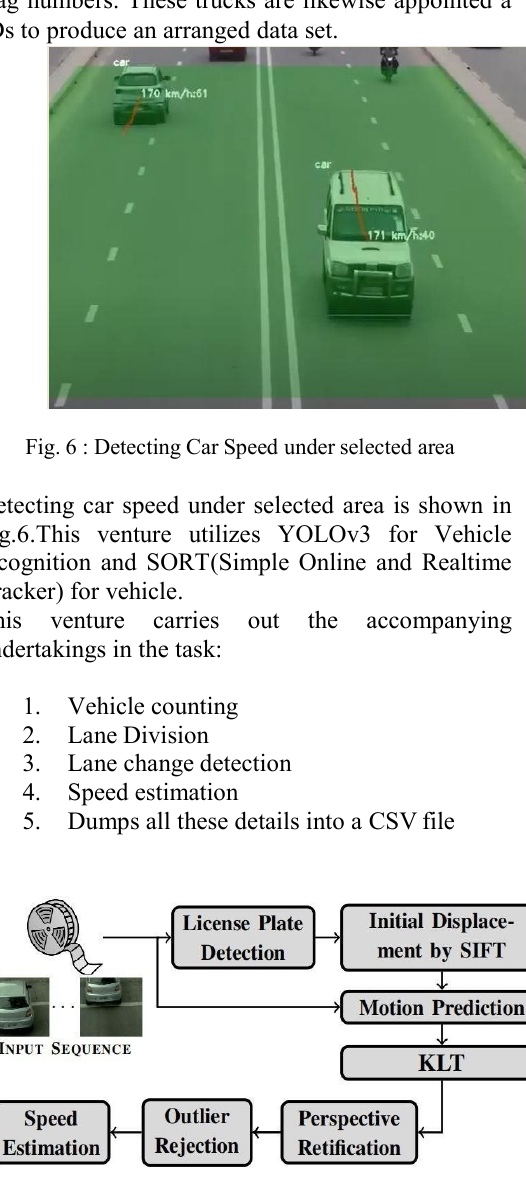
Fig. 7: Overview of the proposed system of Speed